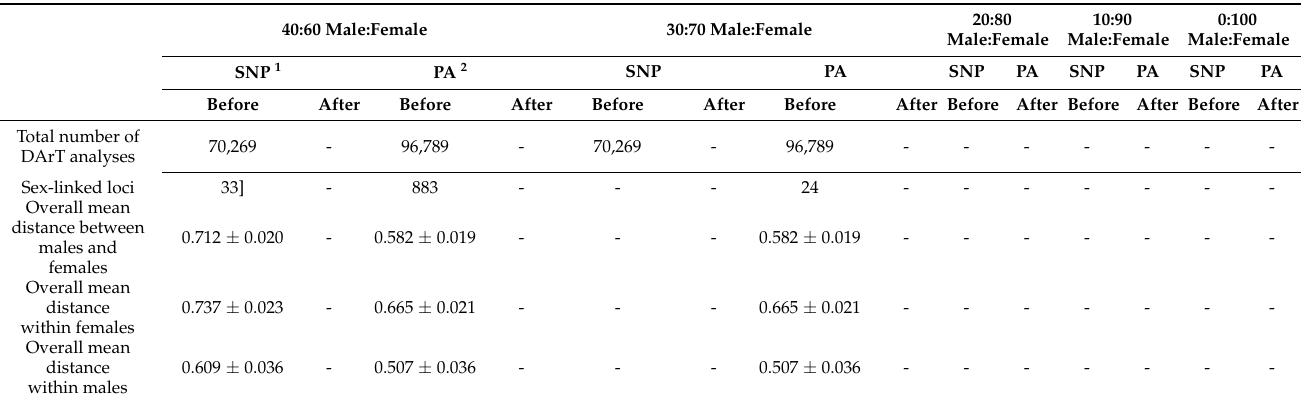
Table 2. DArT analysis of 10 male and 12 female rice field frogs ( Hoplobatrachus rugulosus , Wiegmann, 1834) (ZZ/ZW sex determination type).